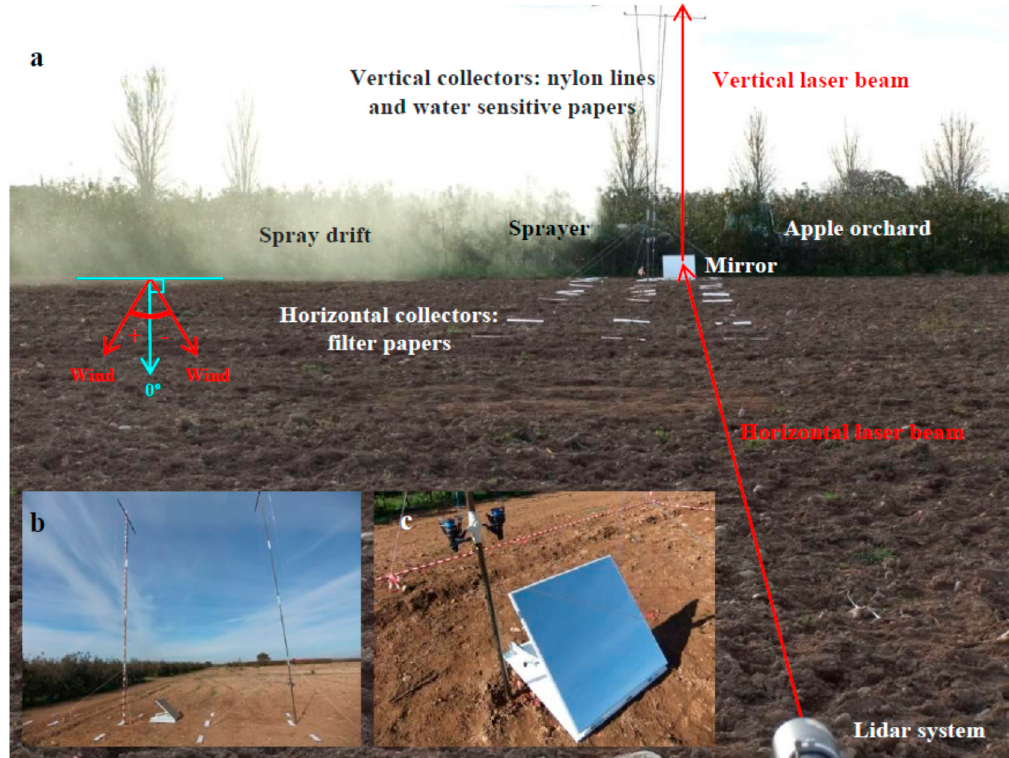
Figure 3. Experimental setup of the ISO 22866 [1] and simultaneous lidar measurements: ( a ) General view of the apple orchard experimental site with relative position of the sprayer, lidar system, mirror, and passive collectors; ( b ) Side-view detail showing the two poles, each one holding two nylon lines; ( c ) Magnified detail of the mirror placed near the pole at 5 m downwind from the first tree row.